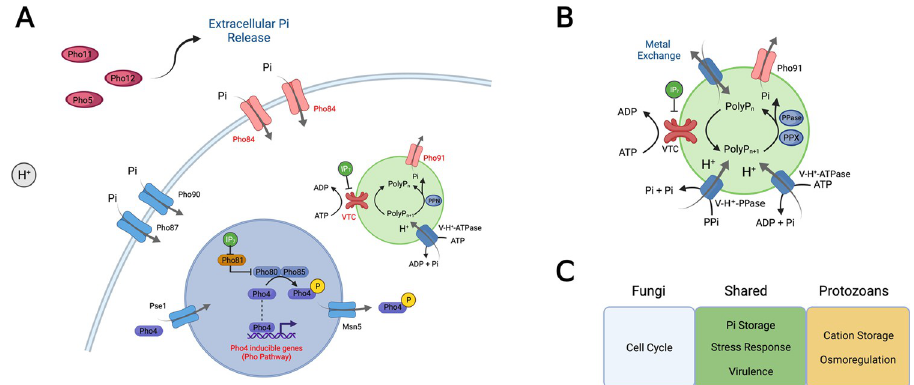
Fig 1. Pi homeostasis in unicellular eukaryotes shares conserved features and roles. (A) In fungi, a Pi sensing system has been described that coordinates Pi mobilization from the environment with Pi uptake and storage as PolyP. When kept at proper Pi levels, the low-affinity Pi transporters Pho87 and Pho90 regulate Pi import from the external medium. Upon reduction of cytoplasmic Pi levels, Pho81 inhibits the Pho4 phosphorylating activity of the cyclin-CDK Pho80-Pho85, preventing the nuclear export of phosphorylated Pho4 by Msn5. Unphosphorylated Pho4, which enters the nuclei by interaction with Pse1, is a transcription factor that drives the expression of several genes involved in Pi mobilization and uptake (in red letters). VTC activation drives vacuolar PolyP synthesis, which acts as a Pi reservoir mobilized by specific polyphosphatases. Levels of InsPi, such as 5-diphosphoinositol pentakisphosphate (IP7), correlate with cellular Pi levels and regulate several proteins involved with Pi homeostasis through binding with their SPX domains. (B) Protozoan acidocalcisomes share several features also found in fungi vacuoles, such as ATP-dependent H + -pumps (V-H + -ATPase), VTC, and phosphate exporters. Acidocalcisomes pH is also regulated by the presence of a PPi-dependent proton pump (V-H + -PPase), which have not been not found in the genome of fungi. Acidocalcisomes also have several cation channels that drive cation homeostasis, which has not been as extensively investigated in fungi models. (C) PolyP and Pi homeostasis collectively have several roles in cellular physiology and disease progression, some of which have been demonstrated in both models. CDK AU : AnabbreviationlisthasbeencompiledforthoseusedinFig 1 : Pleaseverifythatallentriesarecorrect : , cyclin-dependent kinase; VTC, vacuolar transporter chaperone complex.